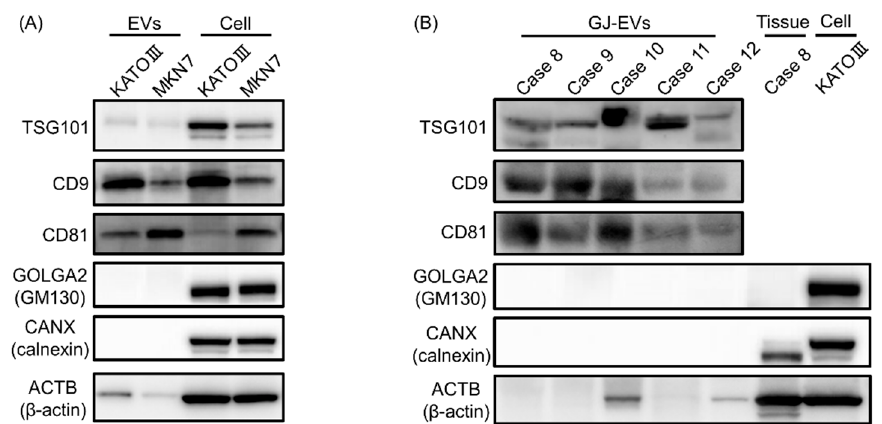
Figure 4. Protein markers of EVs were expressed in isolates from GJ. ( A ) Protein expression profiles of EVs from KATOIII and MKN-7 cell lines are shown. GOLGA2 (GM130) and CANX (calnexin) are used as negative indicator of EVs; ( B ) Those of the EVs of GJ from GC patients. Five cases (cases 8–12) of EVs from GJ were examined.